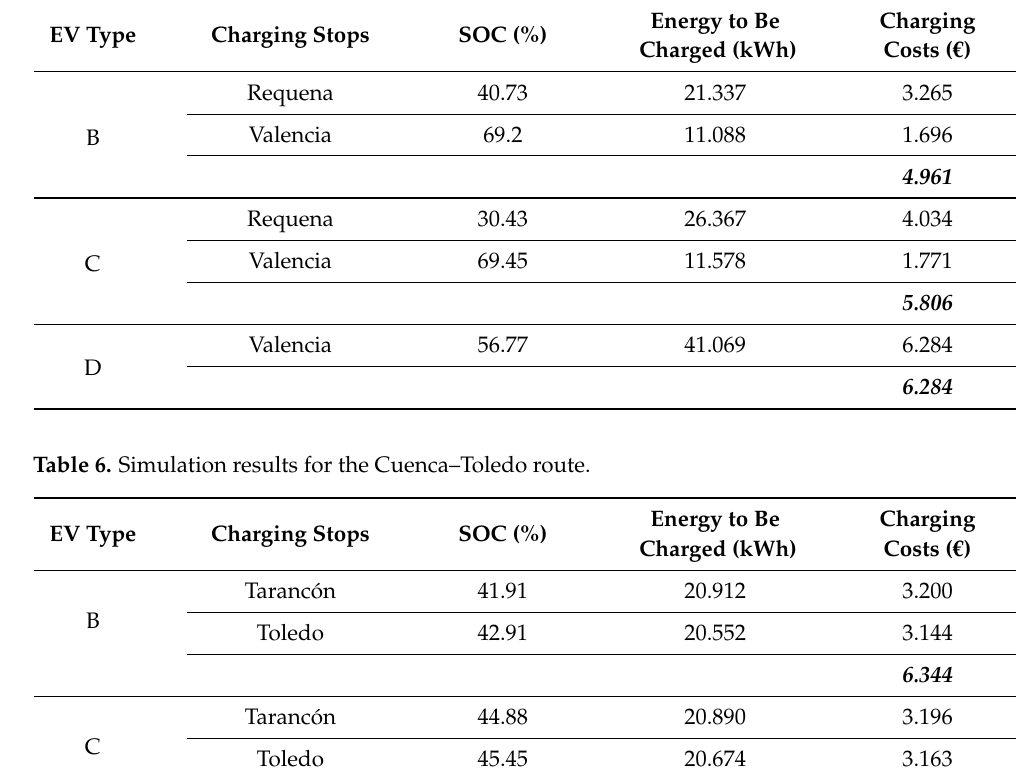
Table 5. Simulation results for the Cuenca–Valencia route.